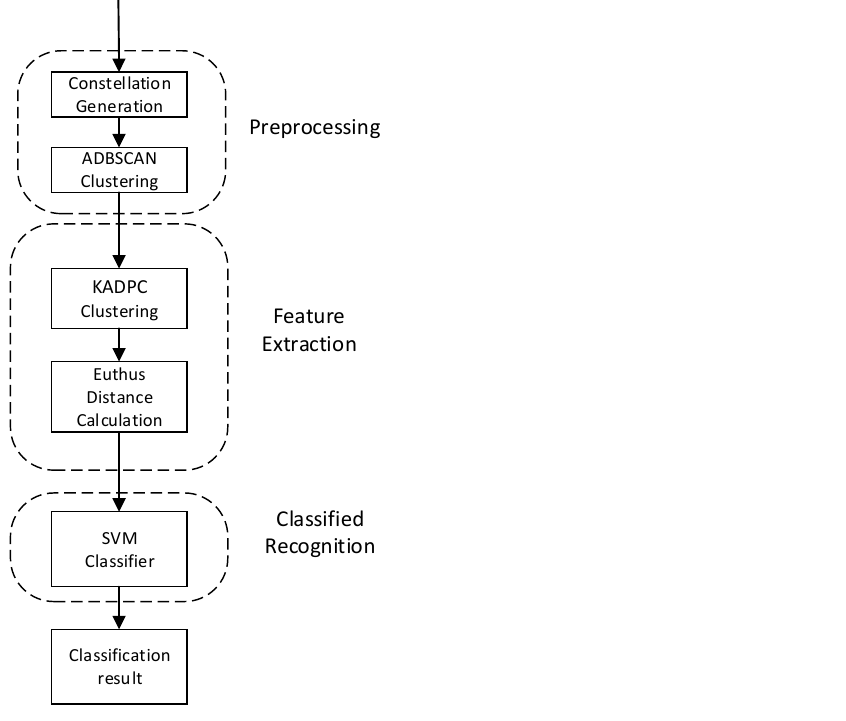
Figure 1. The block diagram of the proposed digital modulation recognition system.